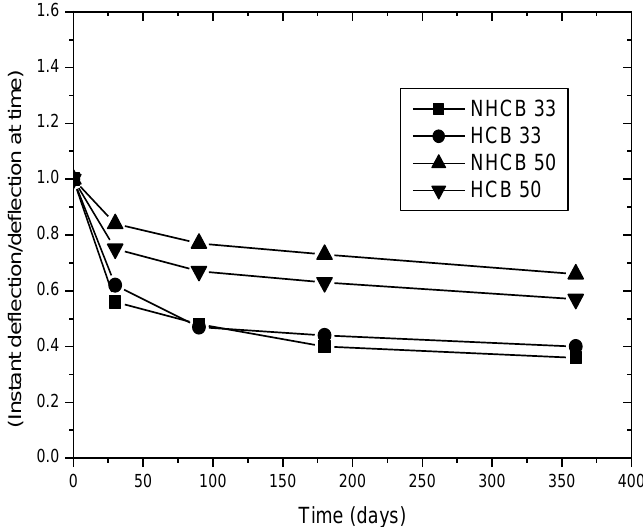
Figure 7. Variation of instantaneous deflection/deflection up to 1 year.